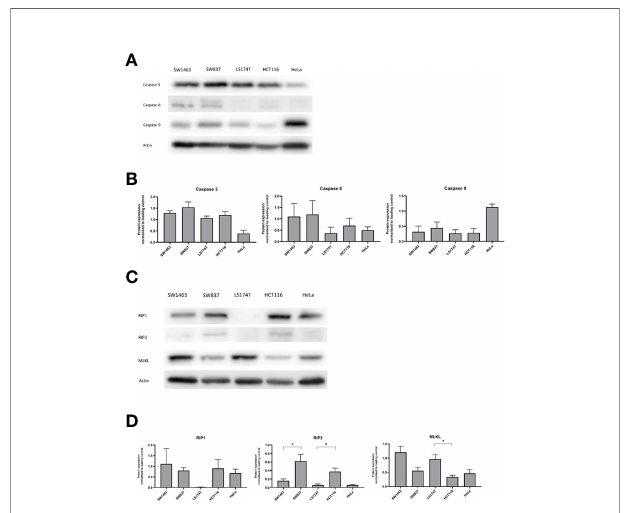
FIGURE 3 | Pro-Caspase protein and Necroptosis protein levels in mucinous versus non-mucinous colon and rectal cancer cell lines. (A) Representative blots of pro-Caspase proteins at baseline; (B) Pro-Caspase protein expression normalized to loading control; (C) Representative blots of necroptosis proteins at baseline; (D) Necroptosis protein expression normalized to loading control. *p<0.05. p value for t test comparing mucinous versus non mucinous cell lines in colon and rectal cancer. N=3 experimental repeats.